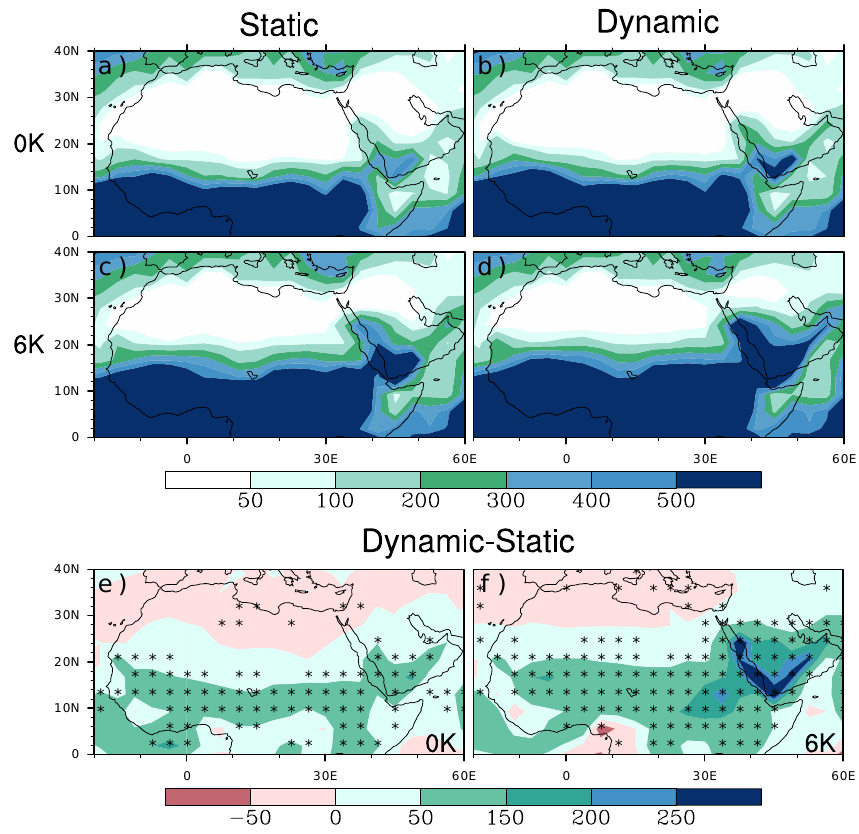
Fig. 4. Precipitation (mmyear − 1 ) averaged over 100 years for (a) 0K st, (b) 0K dyn, (c) 6K st, (d) 6K dyn. Differences in annual mean precipitation between (e) 0K dyn and 0K st, (f) 6K dyn and 6K st, gridbox differences significant (Student’s T-test) at the 95% level are marked with an